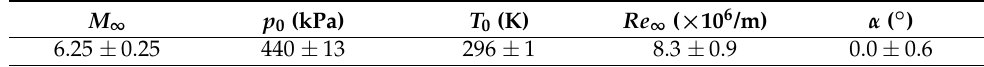
Table 1. Flow conditions in the ACT-1 wind tunnel.